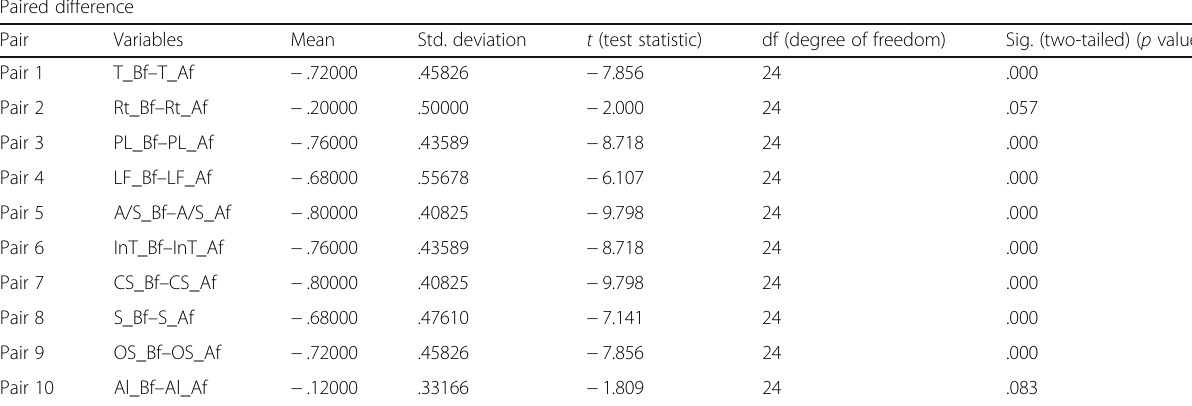
Table 4 shows paired samples t test results in detail with means of difference of “ Bf ” and “ Af, ” standard deviation values, significance values (two-tailed), t values and degree of freedom obtained from analysis of handwriting characteristics in case of Parkinsonism